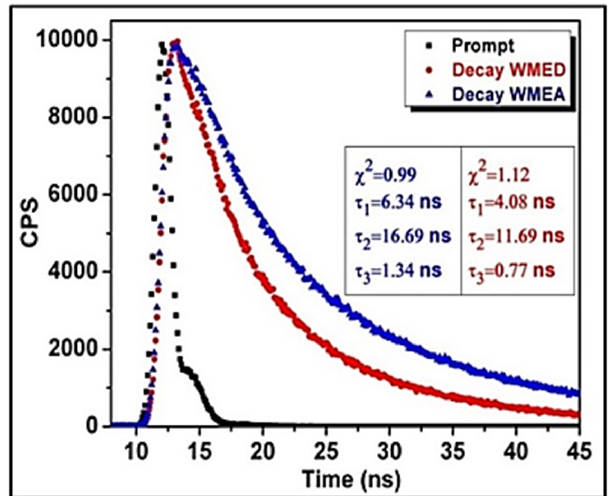
Figure 2. Time-resolved fluorescence decay of WMEA-CQDs ( λ ex = 390 nm and λ em = 460 nm) and WMED-CQDs ( λ ex = 390 nm and λ em = 470 nm) in aqueous medium.